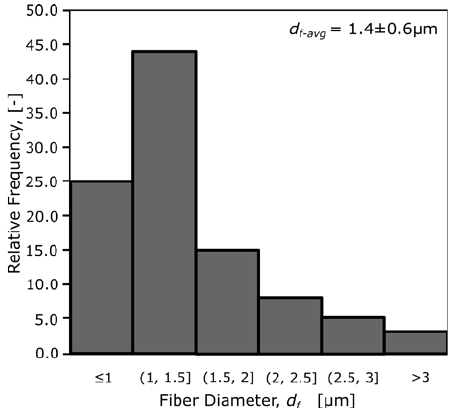
Figure 4. Electrospun polycaprolactone (PCL) mat characterization.